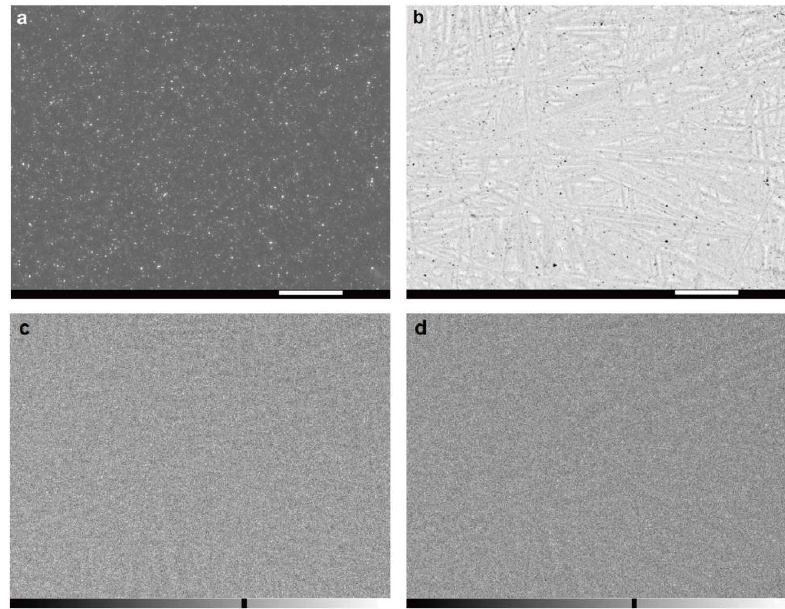
Figure 4. Cross-sectional ( a ) secondary-electron and ( b ) back-scattered-electron SEM images of the f-TiZr alloy along with the scale bars with 10 μm in length. ( c ) Ti and ( d ) Zr concentration maps of the f-TiZr alloy obtained by EDS along with intensity scale bars (below each image where the left-end color shows no intensity) and averaged intensity (black line in each bar). All these images have identical spacial scale to that of Figure 3c,d.